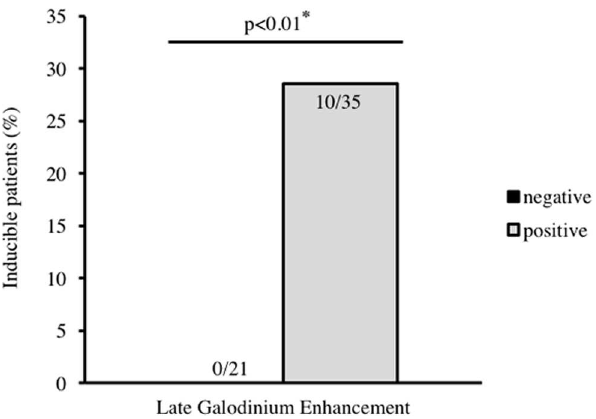
Fig 3. Association of ventricular inducibility with late gadonlinium enhancement in contrast- enhanced cardiac MRI. Fig 3 depicts the associationof ventricularinducibilityin patients with non-ischemic cardiomyopathy and the detectionof positive late gadoliniumenhancement in contrast-enhancedcardiac MRI. Ventricularinducibilitycorrelates significantly with the presenceof late gadoliniumenhancement, p < 0.01.